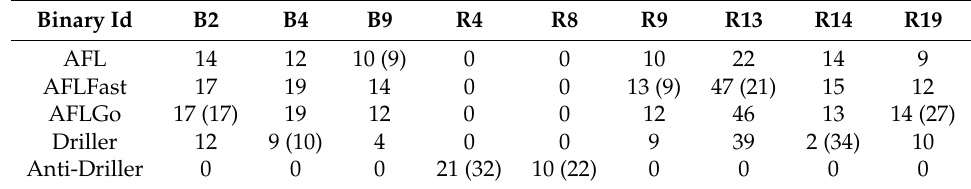
Table 3. The number of crashes found by different vulnerability discovery methods for each binary, where the parameters in the first line represent the binary ids. The number in the bracket indicates the time (minutes) that the first exploitable crash is produced.